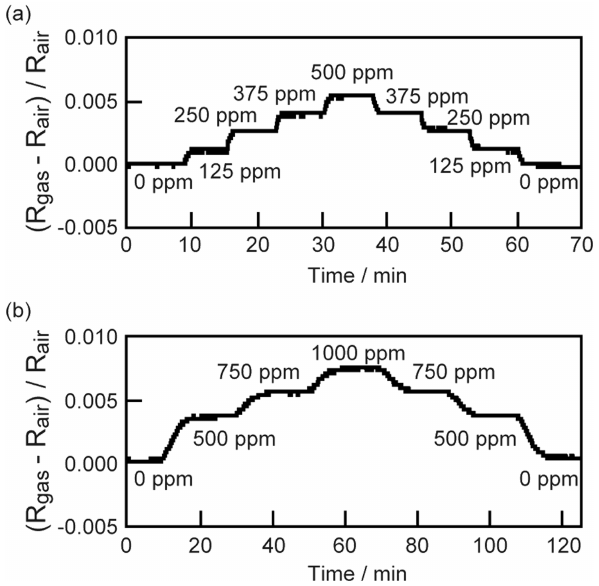
Figure 2. Representative response curves at 70 ◦ C for sensors (a) with and (b) without the AlN intermediate heat transfer layer.